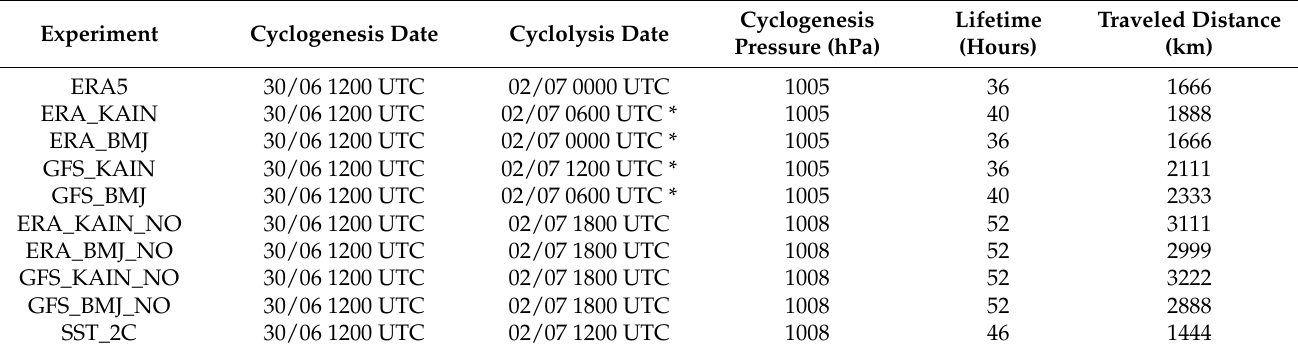
Table 4. Cyclone lifetime in the numerical experiments. In cyclolysis date, * indicates if the cyclone has association with another cyclone center, such as in